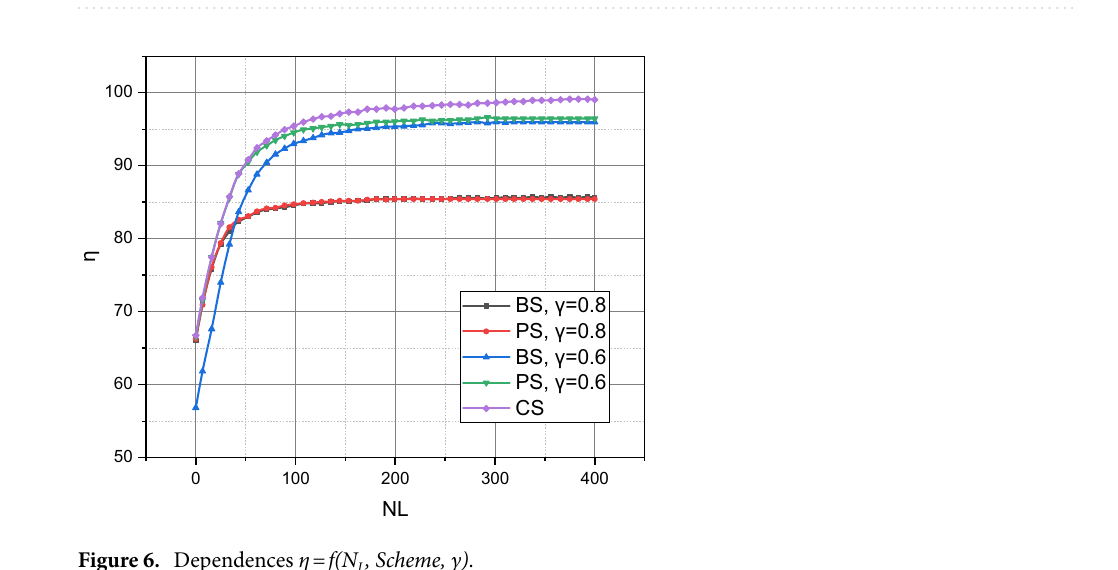
Figure 5. Dependences η = f(N N , Scheme, γ) .